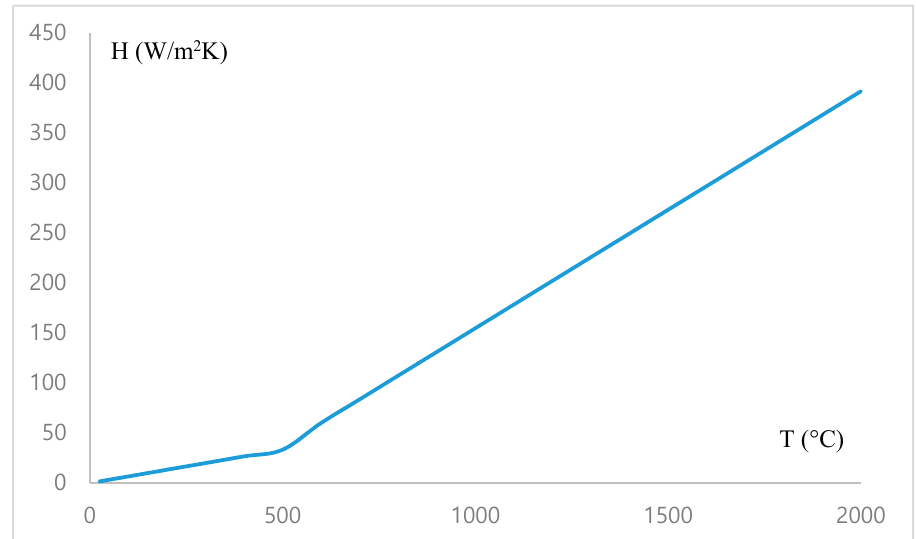
Figure 10. Temperature-dependent film coefficient.